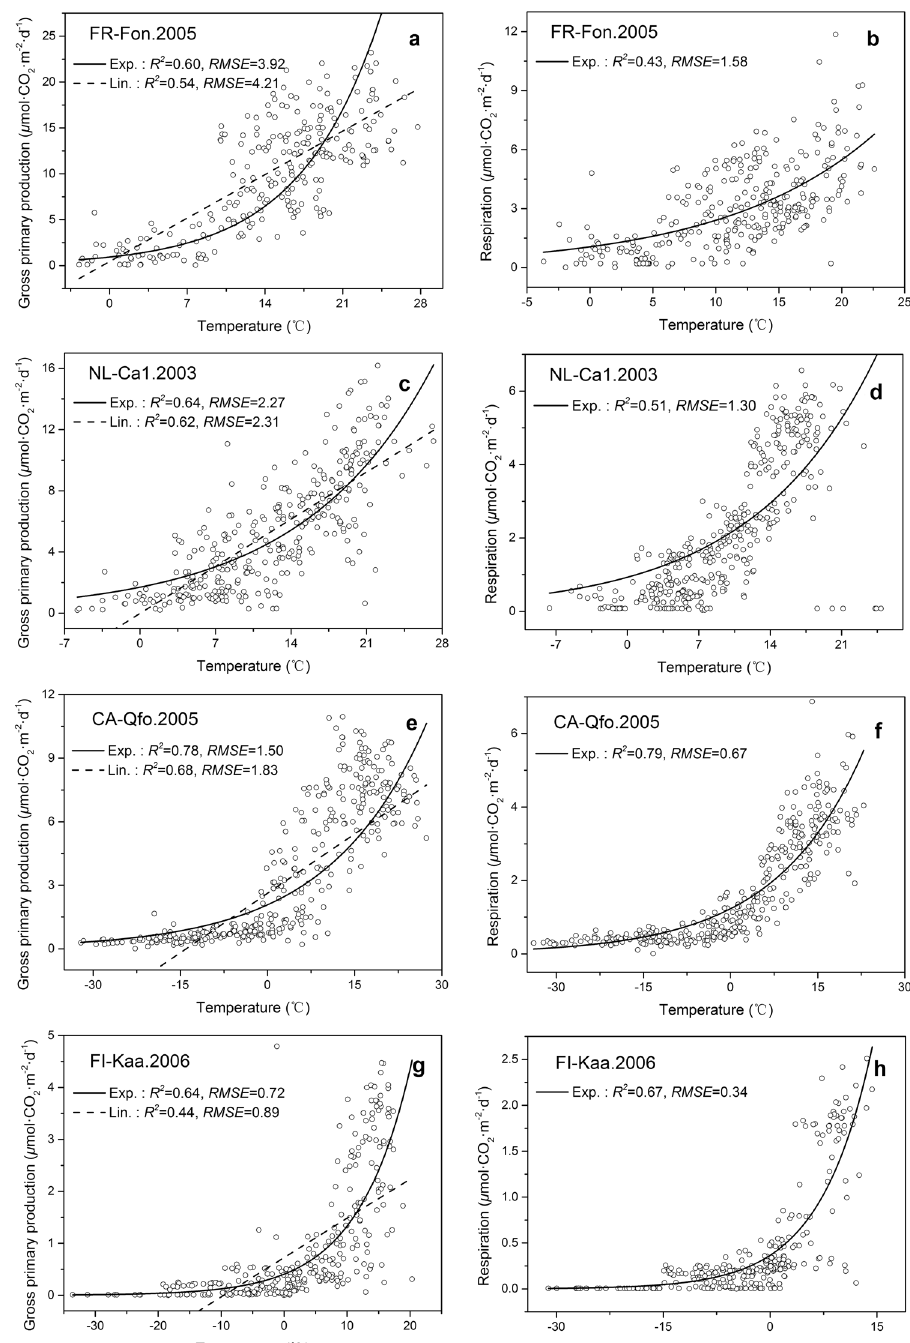
Figure 1. Fitting results using different models to gross primary production rates (GPP) and respiration rate (RE) vs. temperature. The exponential model (i.e., the Q 10 approach, Exp.) and the linear function model (Lin.) were used to gross primary production rates (GPP) vs. temperature at site-years of ( a ) FR-Fon.2005, ( c ) NL-Ca1.2003, ( e ) CA-Qfo.2005, and ( g ) FI-Kaa.2006, and the exponential model was used to fit respiration rates (RE) vs. temperature at site-years of ( b ) FR-Fon.2005, ( d ) NL-Ca1.2003, ( f ) CA-Qfo.2005, and ( h ) FI- Kaa.2006. Sites of FR-Fon, NL-Ca1, CA-Qfo, and FI-Kaa represent ecosystems featuring with climate regions (i.e., temperate and boreal) and plant functional types (PFTs) (i.e., forest and non-forest) of temperate & forest, temperate & non-forest, boreal & forest, and boreal & non-forest, respectively. Comparison of the fitting results was based on the coefficients of determination ( R 2 ) and root mean square error ( RMSE